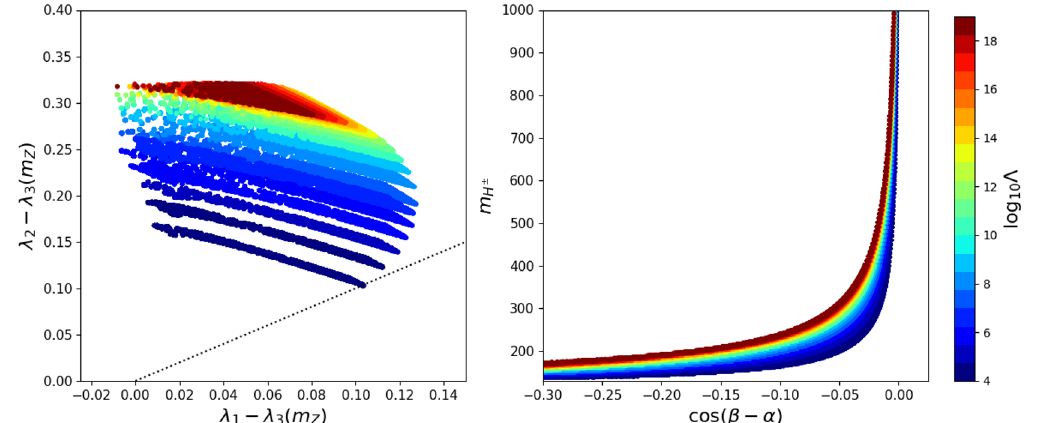
Figure 2 . (Left) Values of λ 1 − λ 3 and λ 2 − λ 3 at the electroweak scale for tan β = 5 in Type-I. The dashed line shows the parameter points where λ 1 = λ 2 . (Right) The decoupling behavior in the high-scale twisted-custodial-symmetric scenario. The points in different colors correspond to the different value of Λ